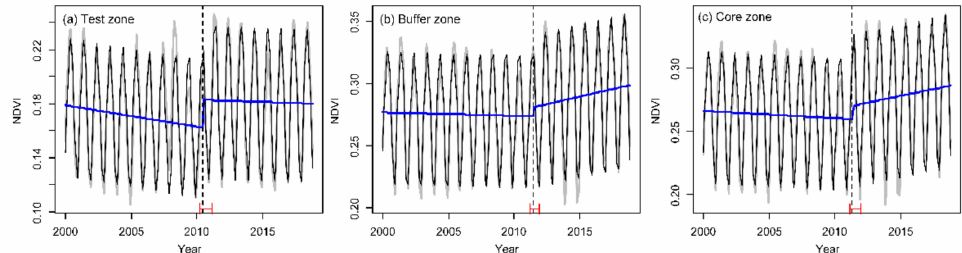
Figure 9. Variations in the NDVI in test zone ( a ), buffer zone ( b ) and core zone ( c ). The black lines represent the seasonal trend model fitted to the original NDVI series (gray lines). The vertical, dashed black lines describe the times of shifts, and the red lines are the confidence intervals. The blue lines are the separate trends detected before and after the shifts.